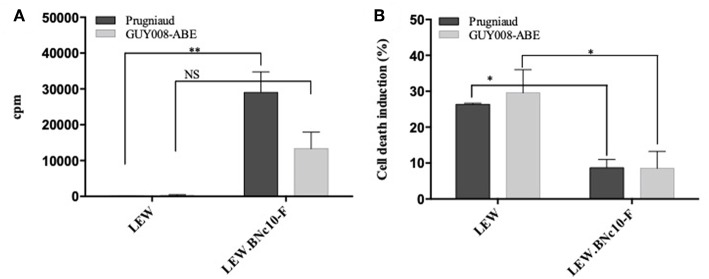
GUY008-ABE parasites do not proliferate in resistant LEW macrophages. (A) Peritoneal macrophages were infected (MOI 1:3) and parasites proliferation assessed by 3H uracil incorporation 40 h post-infection. Results were normalized according to the values obtained in non-infected macrophages. Means ± SEM of 3 independent experiments are represented. (B) Cell death was monitored by propidium iodide (PI, 5 μg/ml) uptake 4 h post-infection. Histograms represent the percentage of PI positive dying cells (results indicate the difference between infected and un-infected cells). Means ± SEM of 3 independent experiments are represented. Values were submitted to 2-way ANOVA analysis followed by a Tukey's multiple comparisons test (*p < 0.05; **p < 0.005). NS, non-significant.